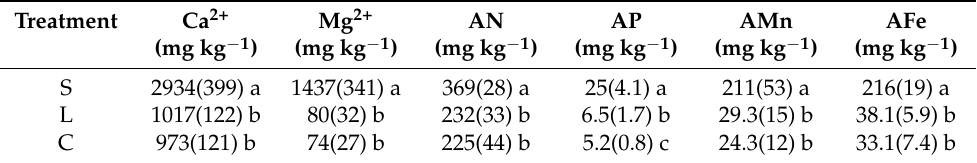
Table 2. Soil easily available nutrients in Stropharia rugosoannulata cultivation